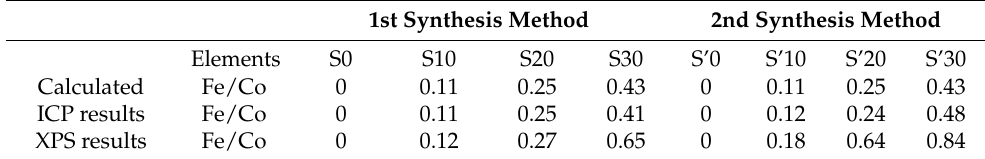
Table 4. Comparison of results of atomic Fe/Co ratio obtained by different analysis